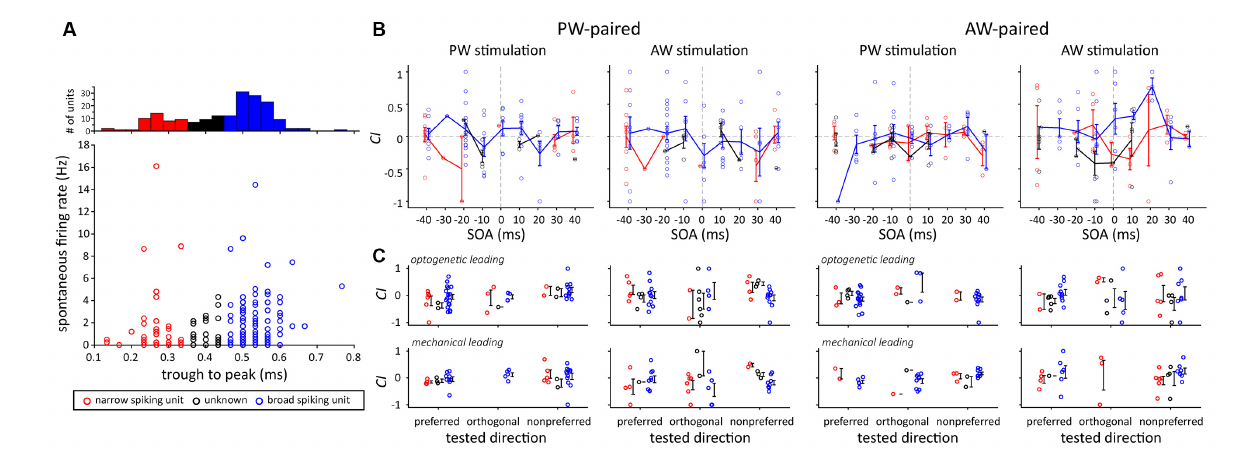
FIGURE 9 | Comparison of CI s between two putative neuron types according to their spike shape. (A) Neuron type categorization based on their trough-to-peak spike width. Three types were assigned, including the narrow spiking (width < 0.35 ms, red dots), broad spiking (width > 0.45 ms, blue dots), and unknown (width ≥ 0.35 ms and ≤ 0.45 ms, black dots) types. (B) The effect of SOA did not differ between the two putative neuron types. The error bar represents the mean ± s.e.m. (C) The effect of paired direction did not differ between the two putative neuron